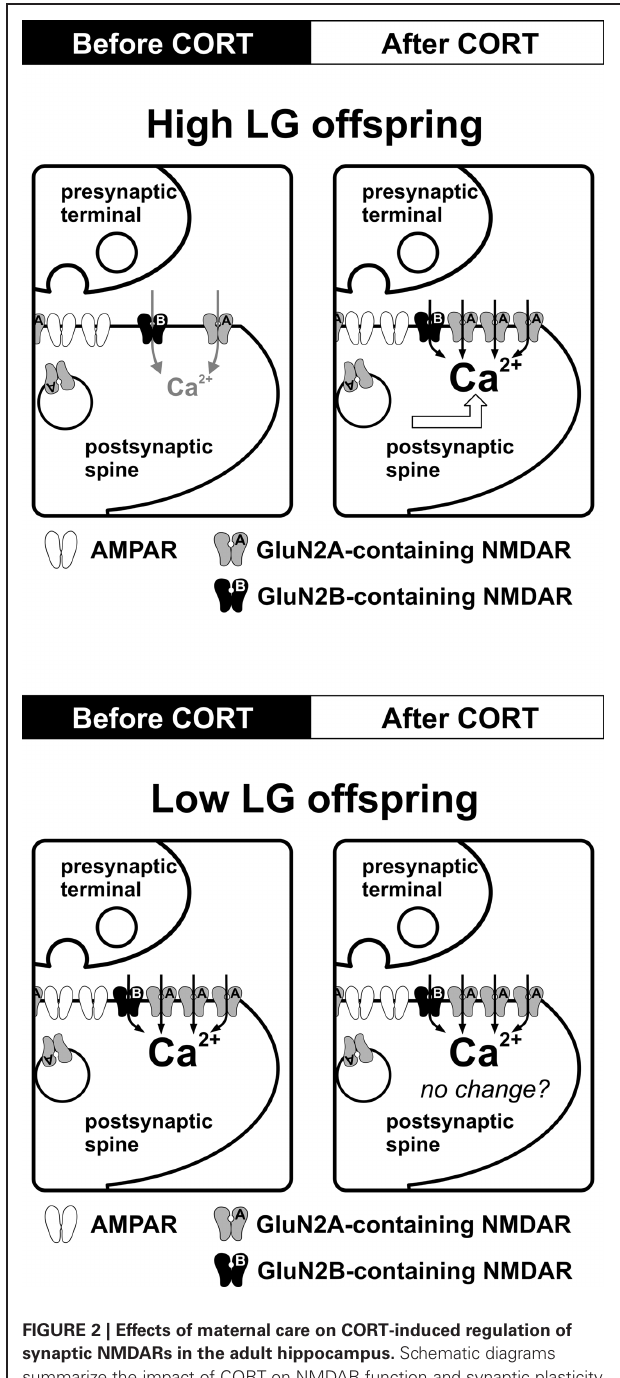
FIGURE 2 | Effects of maternal care on CORT-induced regulation of synaptic NMDARs in the adult hippocampus. Schematic diagrams summarize the impact of CORT on NMDAR function and synaptic plasticity. In High LG offspring, stress level CORT (100nM, 30min) induces a fast-onset increase in synaptic NMDAR current and a reduction of NMDAR decay kinetics, which may result from an increase in synaptic GluN2A expression. The same CORT treatment produces no observable alteration of NMDAR function or decay kinetics in Low LG offspring. Potential alteration of other ionotropic receptors species (e.g., lateral trafficking of AMPAR) after CORT treatment in Low LG offspring has not been